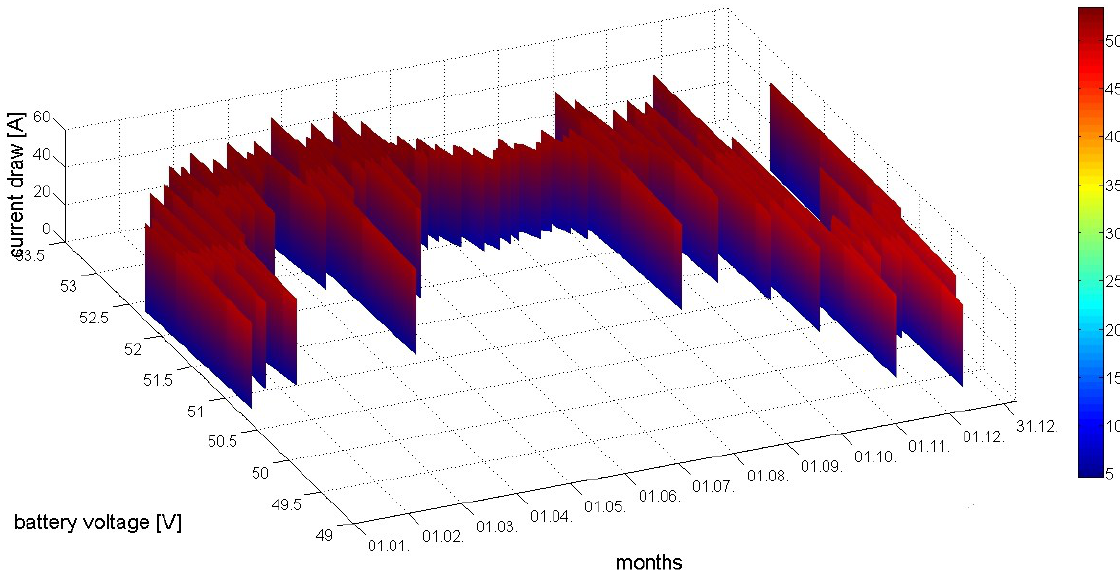
Figure 11. 3D visualization of interdependence among battery voltage and total current draw for the BSS B during one